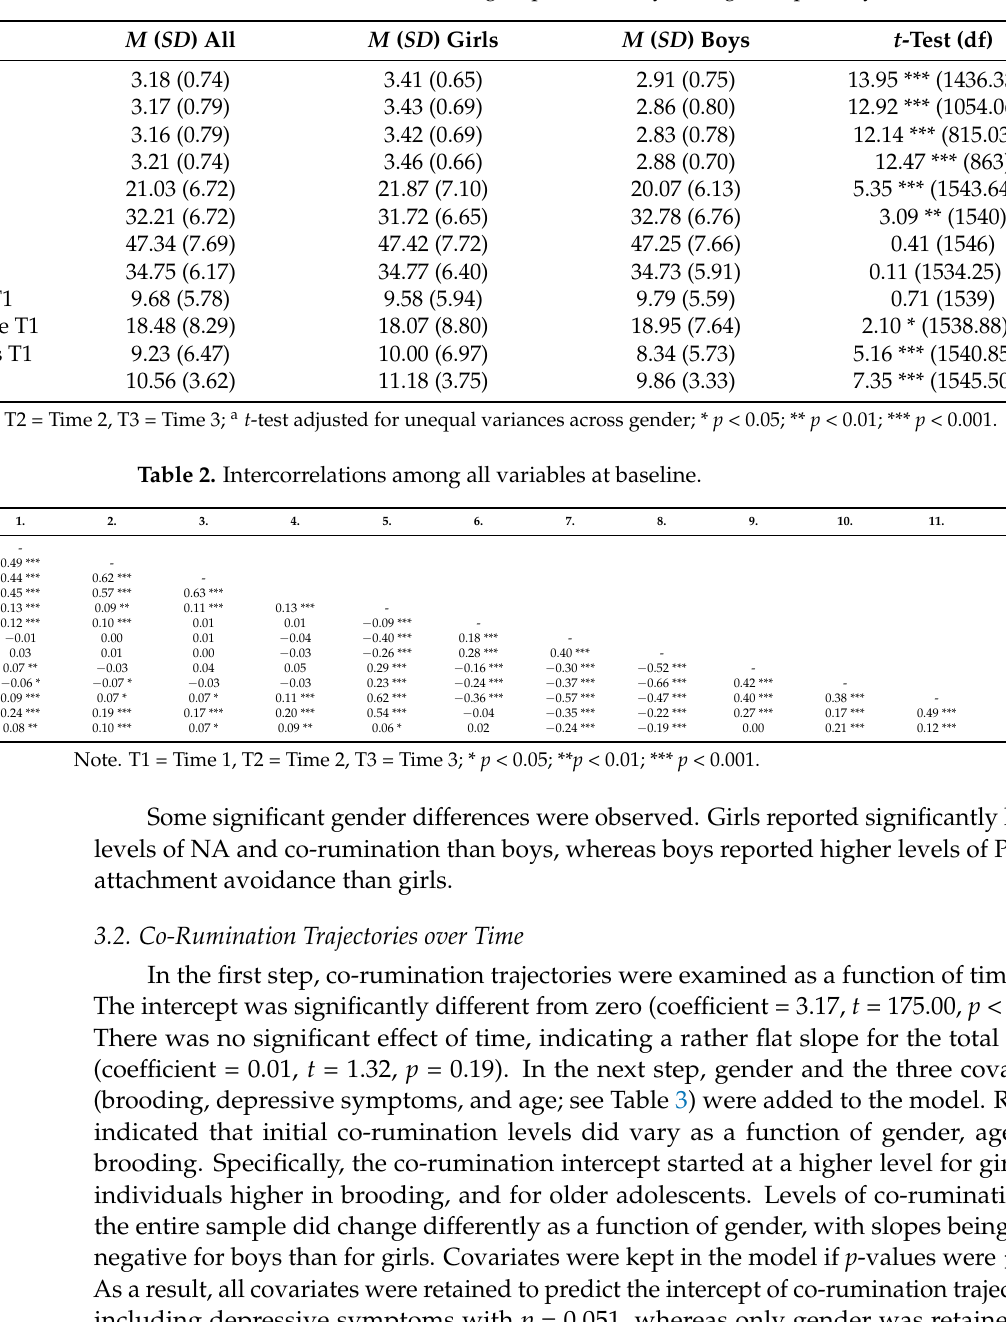
Table 1. Means and standard deviations for the total group and for boys and girls separately.